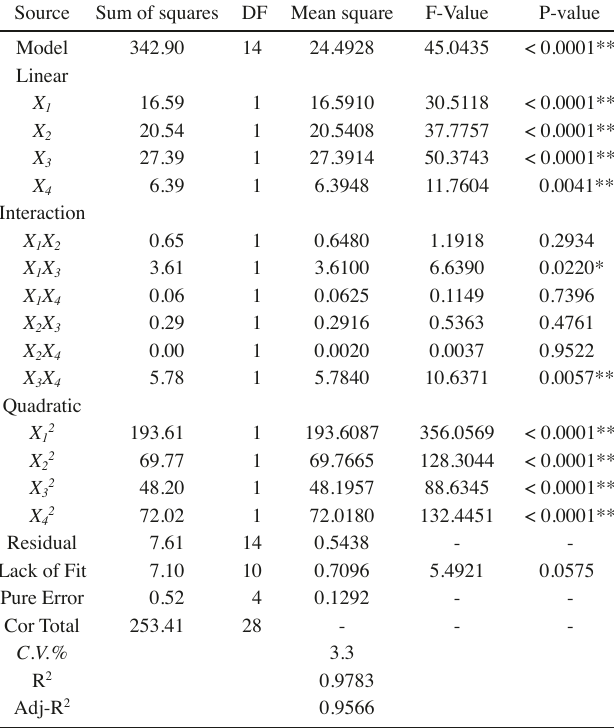
Tab. 3: Results of ANOVA of regression model for the extraction yield of tea polyphenols. Source Sum of squares DF Mean square